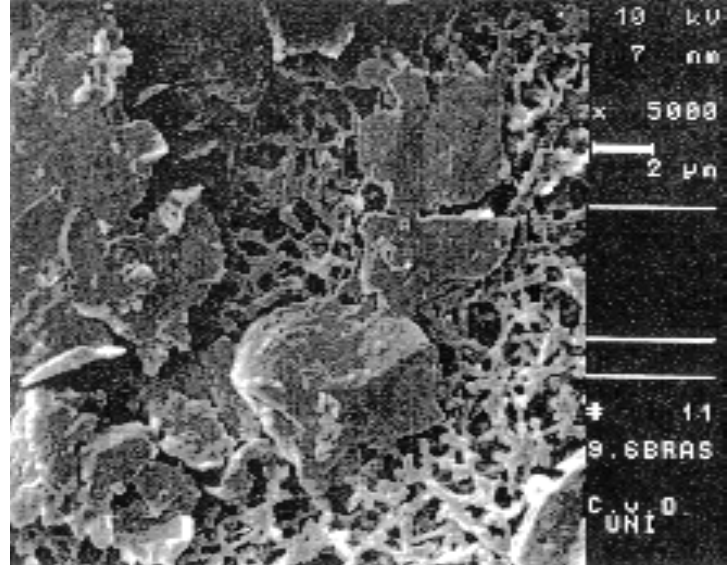
Figura 4. Fotografia obtida por microscopia eletrônica de varredura, mostrando vermiculita